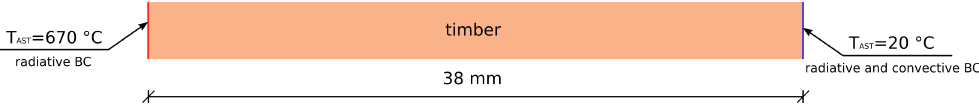
Figure 8. Geometry of Kashiwagi’s et al.